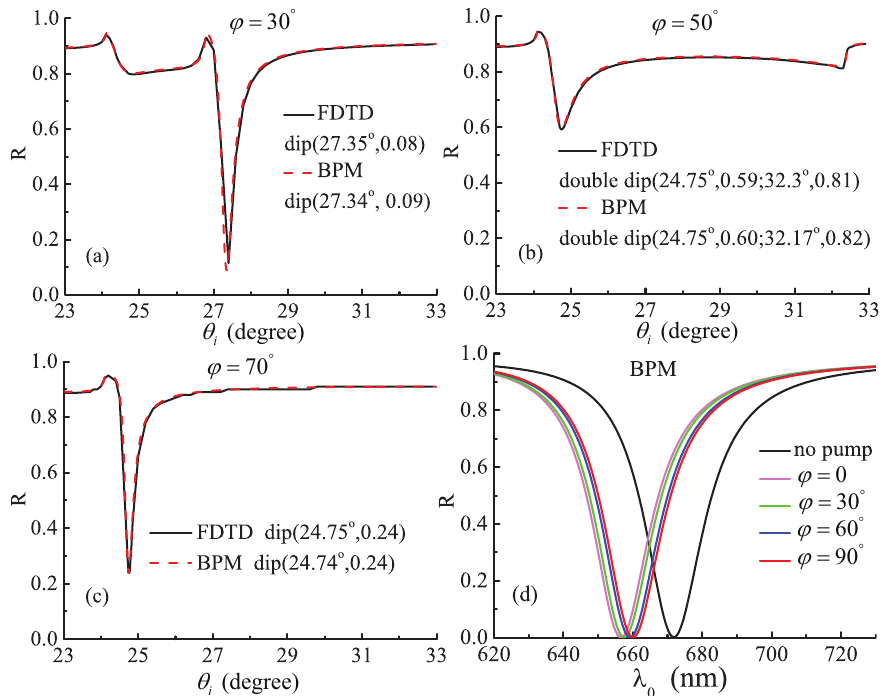
Figure 2. Comparison between attenuated total reflection (ATR) curves from the beam propagation method (BPM) and the standard which are the finite-difference time-domain (FDTD) method and the results of the experiment in the paper [2], respectively. The first three graphs compare with the result of FDTD method; while the last one may be compared with the result of the experiment in the paper [2]. The total reflectivity R is a function of the azimuth angle of the optical axis ϕ , incident angles θ wavelength λ 0